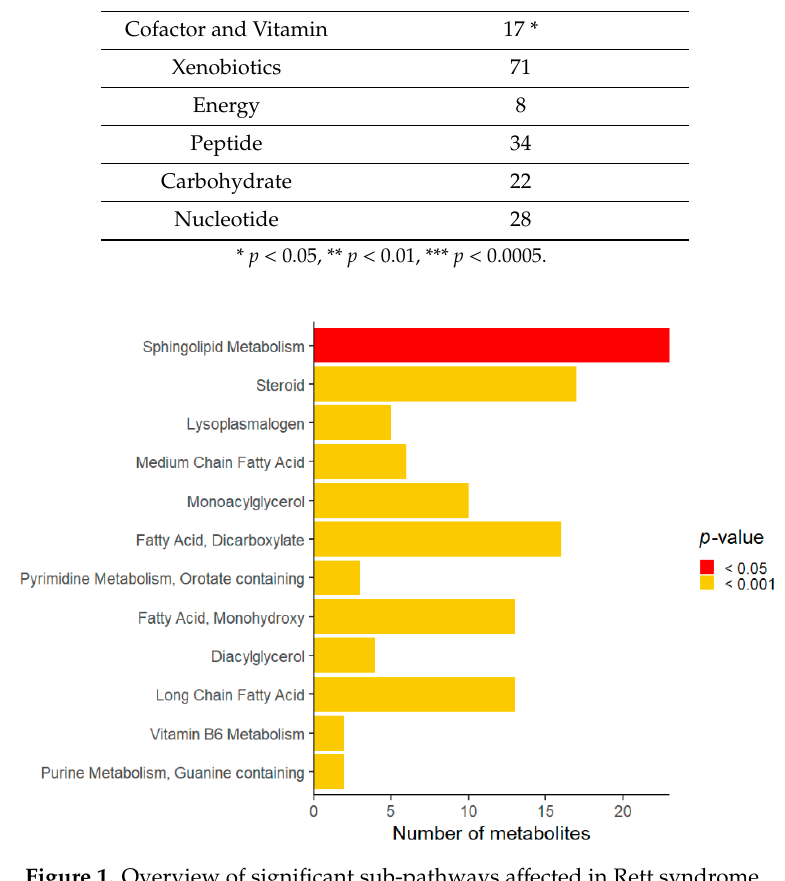
Table 2. Super-pathways analysis on metabolite perturbations detected in Rett syndrome.